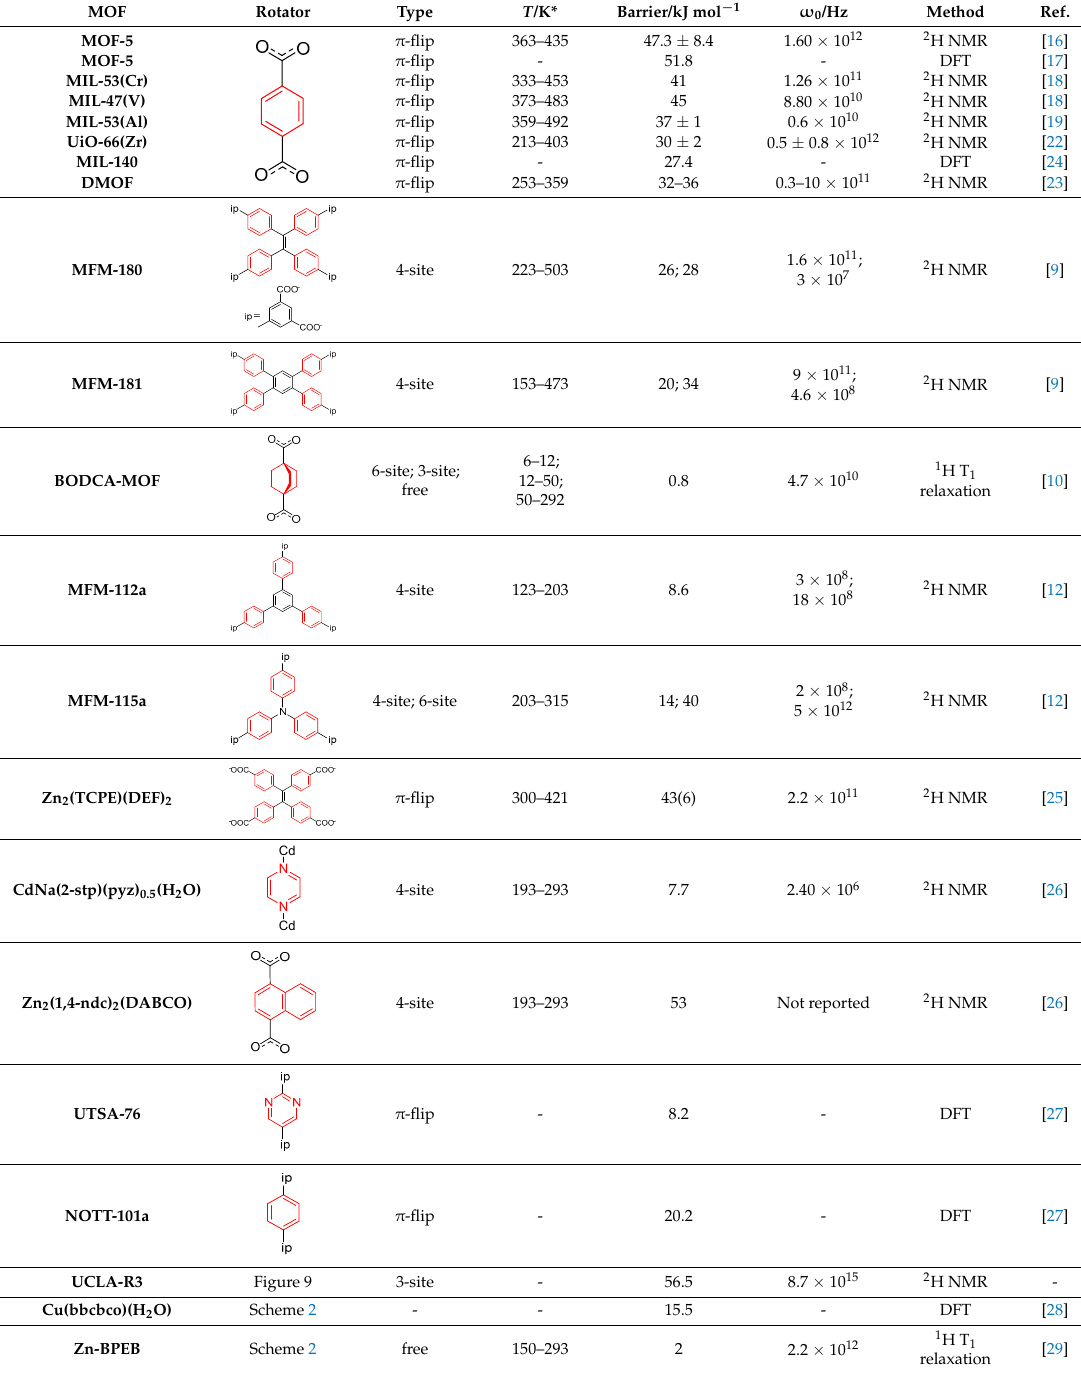
Table 1. Type A rotor linkers and their rotational barriers.